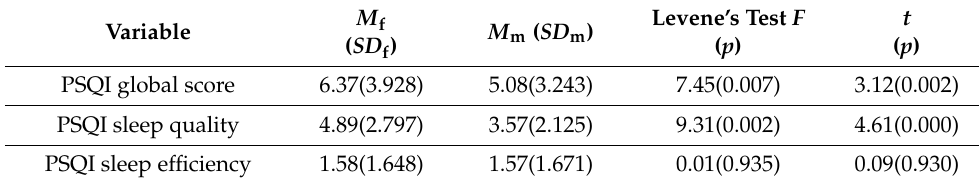
Table 4. Differences in PSQI scores between women (f, n = 175–180) and men (m, n = 121–123) regardless of MS diagnosis.